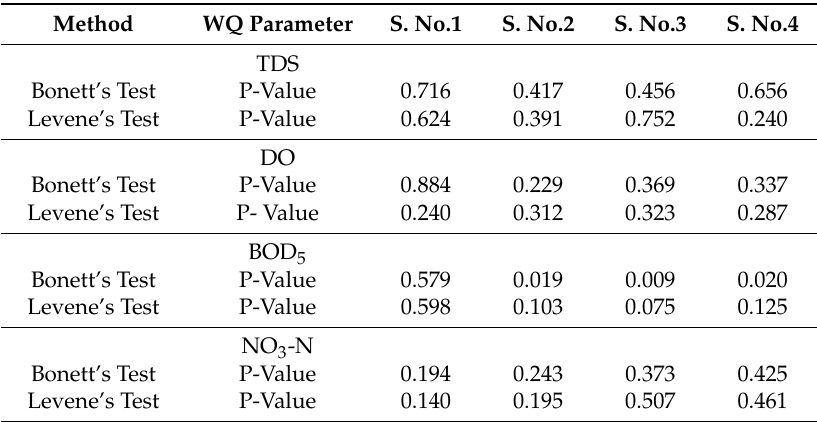
Table 6. Seasonal variances of the WQ parameters for the four